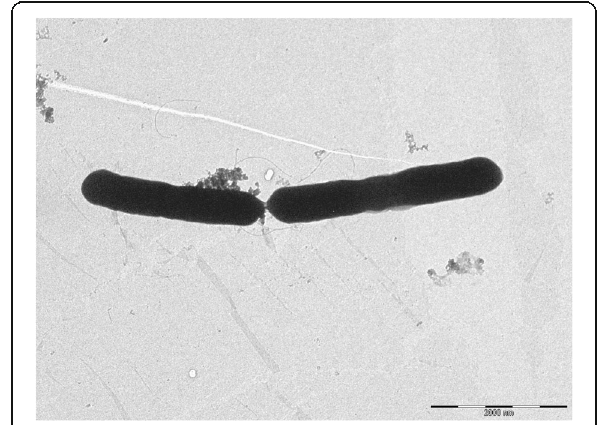
Fig. 1 Transmission electron micrograph of Bacillus amyloliquefaciens subsp. plantarum strain Fito_F321. Bar: 2 μ m